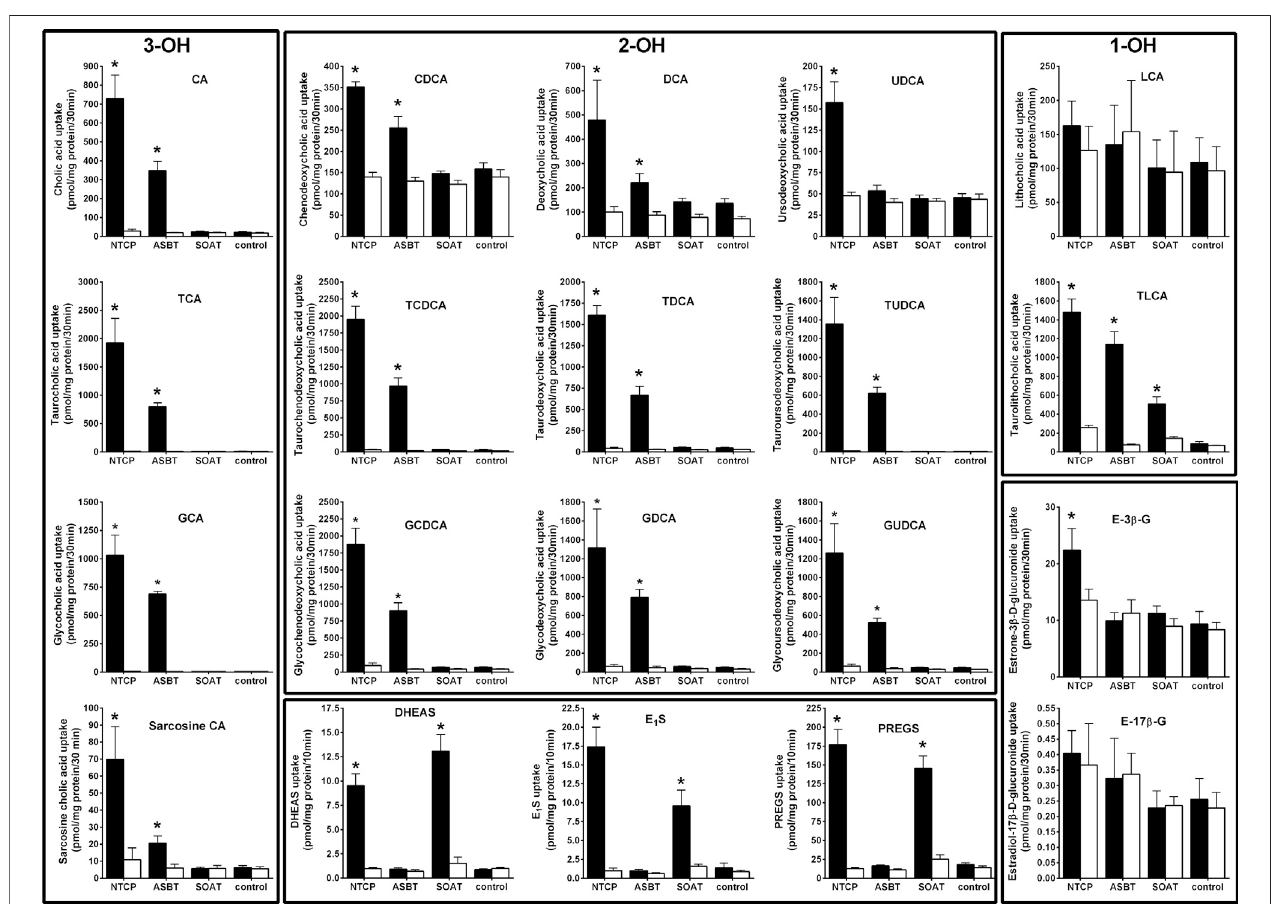
FIGURE 1 | Comparative substrate screening for bile acids and sulfated steroids in NTCP-, ASBT-, and SOAT-HEK293 cells. Transport assays were performed with the indicated substrates in NTCP-HEK293, ABST-HEK293, SOAT-HEK293, and HEK293-FlpIn cells. Cells were washed and equilibrated with Na + -containing transport buffer ( fi lled bars) or with Na + -free transport buffer (open bars) at 37 ° C. For uptake, cells were incubated with radiolabeled steroid compounds at a fi nal concentration of 200 nM in Na + -containing or Na + -free transport buffer for 10 min. Radiolabeled bile acids were used at 1 µM concentrations and transport was analyzed over 30 min. HEK293-FlpIn cells served as additional controls. After the indicated time intervals, cells were washed with ice-cold PBS, lysed and subjected to liquid scintillation counting. Values represent means ± SD of combined data of two independent experiments, each with quadruplicate determinations ( n (cid:1) 8). * p < 0.01 (two-way ANOVA) indicating Na + -dependent uptake (Na + -containing vs. Na + -free transport buffer of the respective cell line). 3-OH, trihydroxylated BAs; 2-OH, dihydroxylated BAs; 1-OH, monohydroxylated